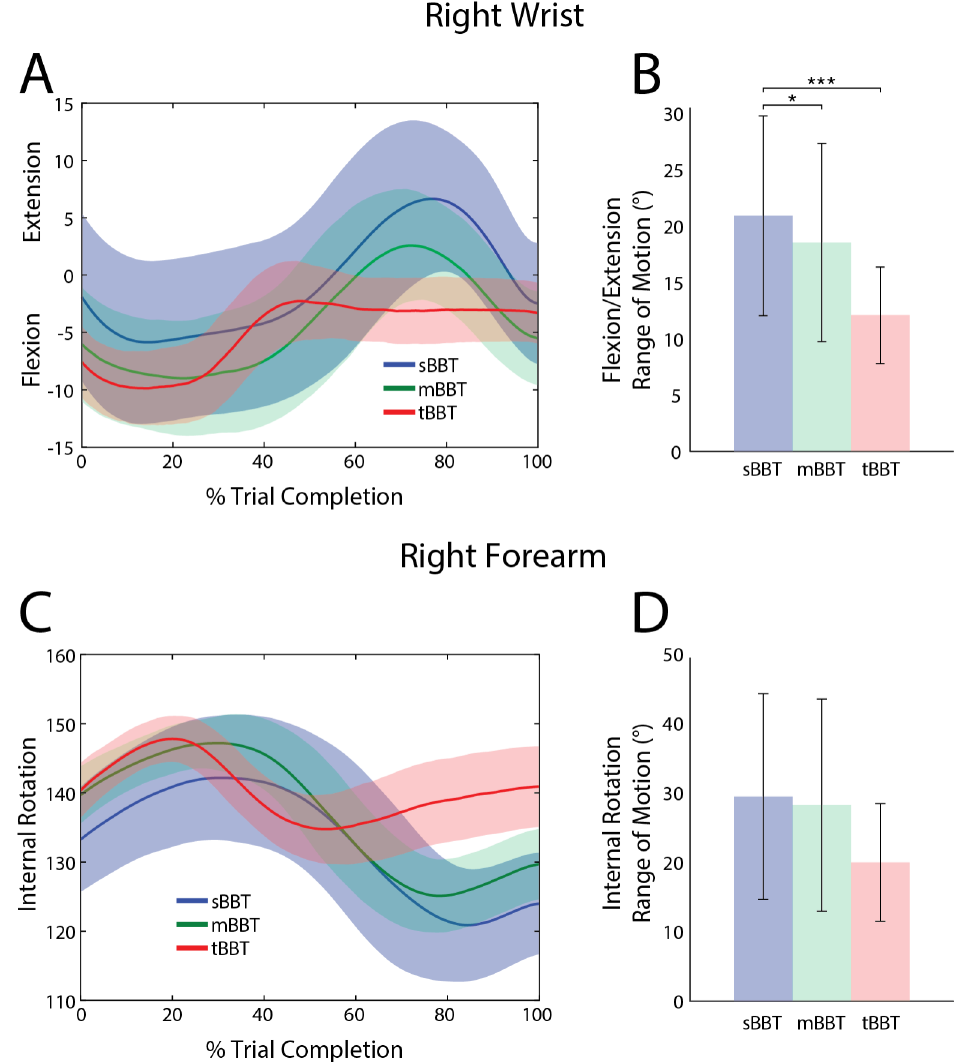
Fig 3. Kinematic trajectoriesand ROM of the wrist/forearm. Kinematic trajectories and ROM of the wrist/ forearm for the sBBT (blue), mBBT (green), and tBBT (red). (A)Wrist flexion/extension and (C) forearm internalrotation trajectories for each test. (B) Wrist flexion/extension RoM and (D) forearm internalrotation RoM for each test.